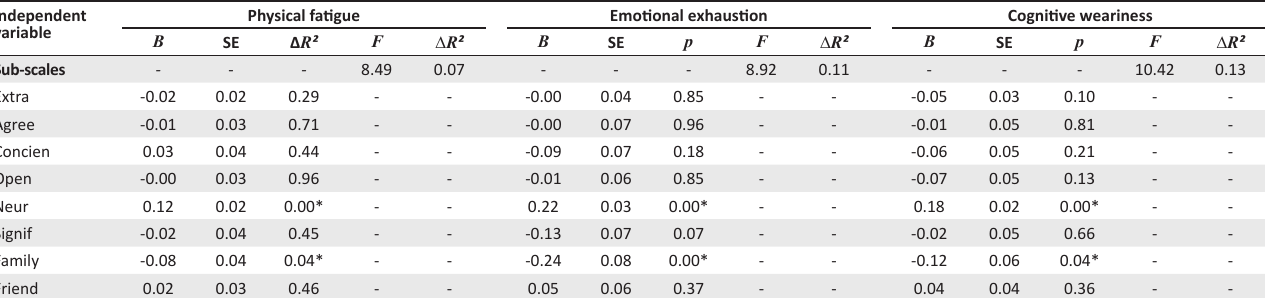
TABLE 2: Multiple regression analysis with dimensions of personality and perceived social support as independent variables and physical fatigue, emotional exhaustion and cognitive weariness as dependent variables. Independent